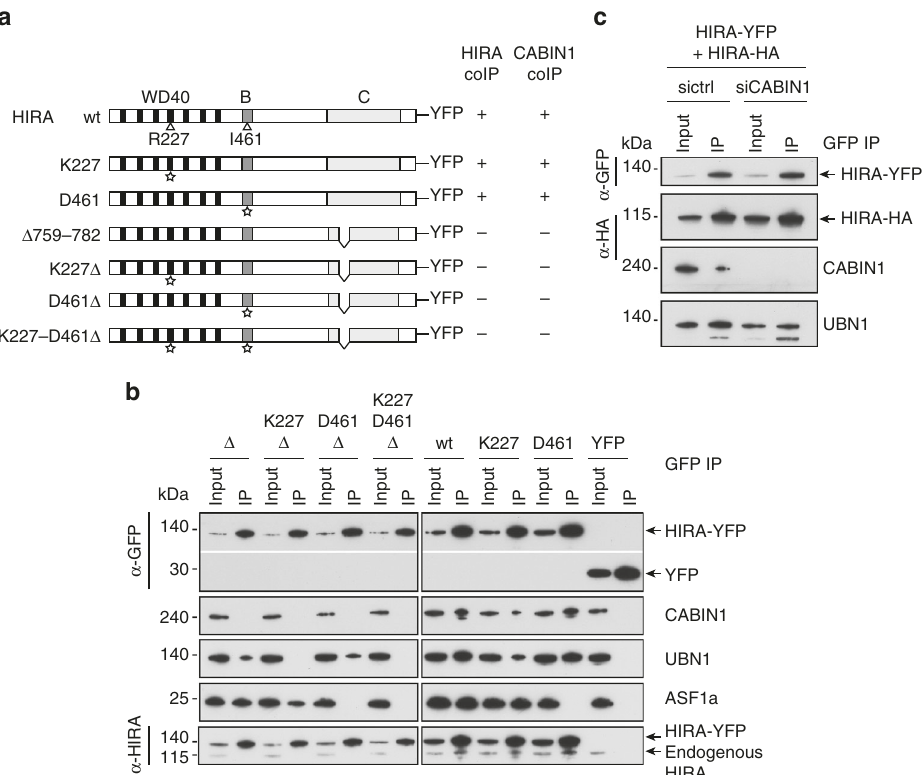
Fig. 2 HIRA homooligomerization is required for CABIN1 interaction. a YFP constructs of human HIRA and mutants. The amino acids R227 and I461 critical for UBN and ASF1a interactions, respectively, are shown. Star indicates single amino acid substitution (R227 with K or I461 with D). The co- immunoprecipitation ef fi ciencies of both endogenous HIRA (HIRA coIP) and CABIN1 (CABIN1 coIP) are indicated for each construct, “ + ” indicates that the ef fi ciency of coIP is similar to the one obtained with the wt HIRA construct and “ − ” indicates that the ef fi ciency of the coIP is decreased. b Western